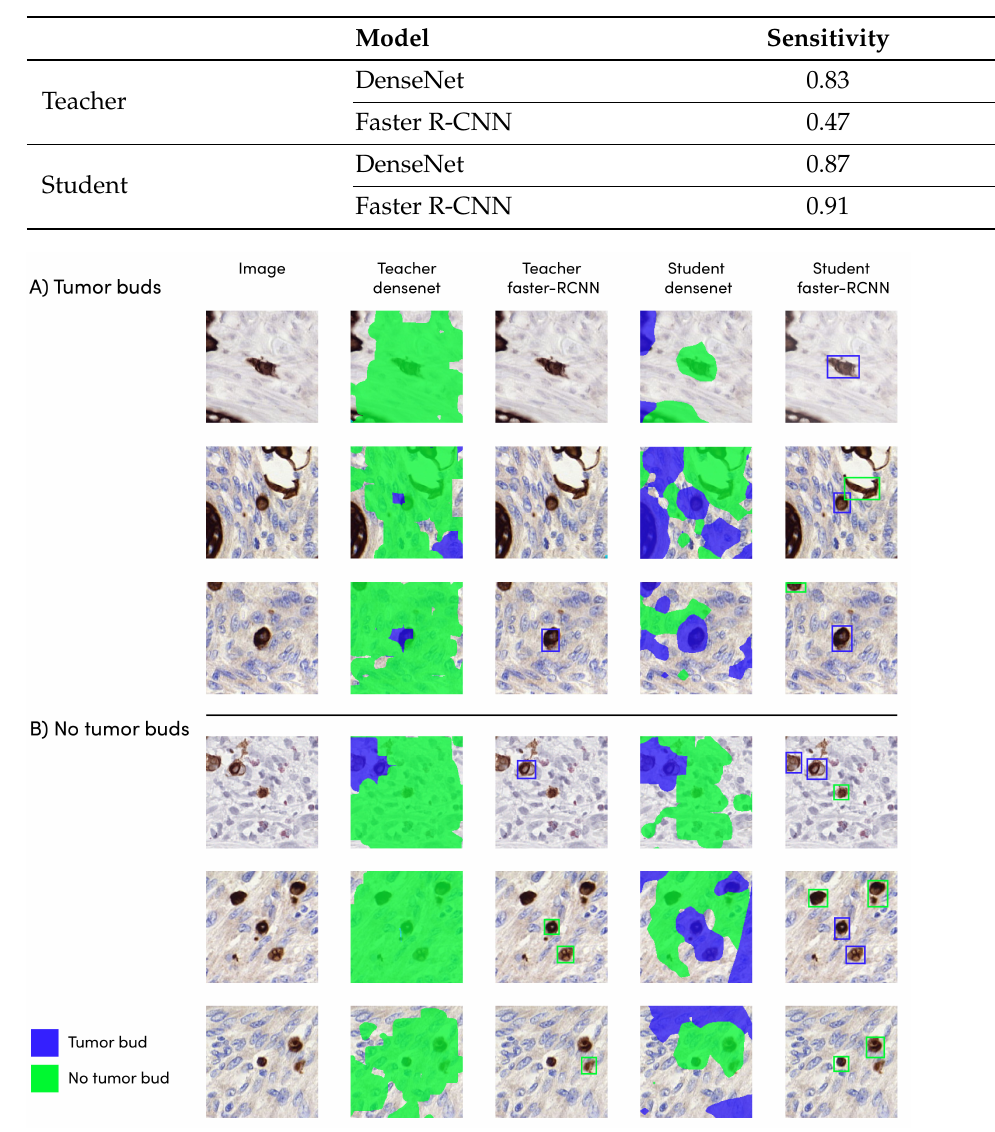
Figure 3. Model output on ( A ) tumor bud and ( B ) no tumor bud. The pixels in green/blue indicate the automatically predicted tumor bud/non-tumor-bud regions. The reference standard labels are related to the object in the center of the